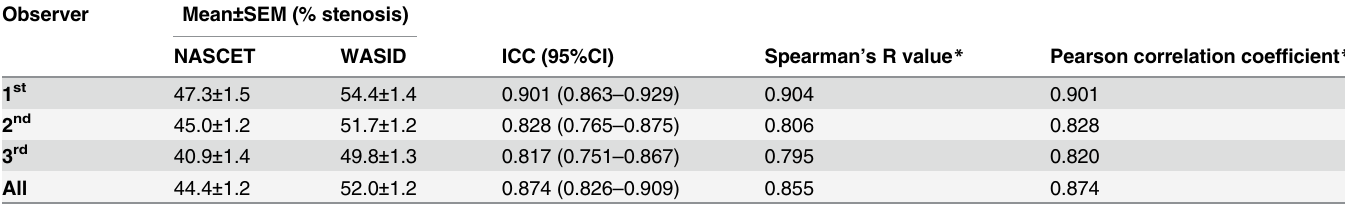
Table 1. Linear correlation between NASCET and WASID methods in each observer and all 3 observers. Observer